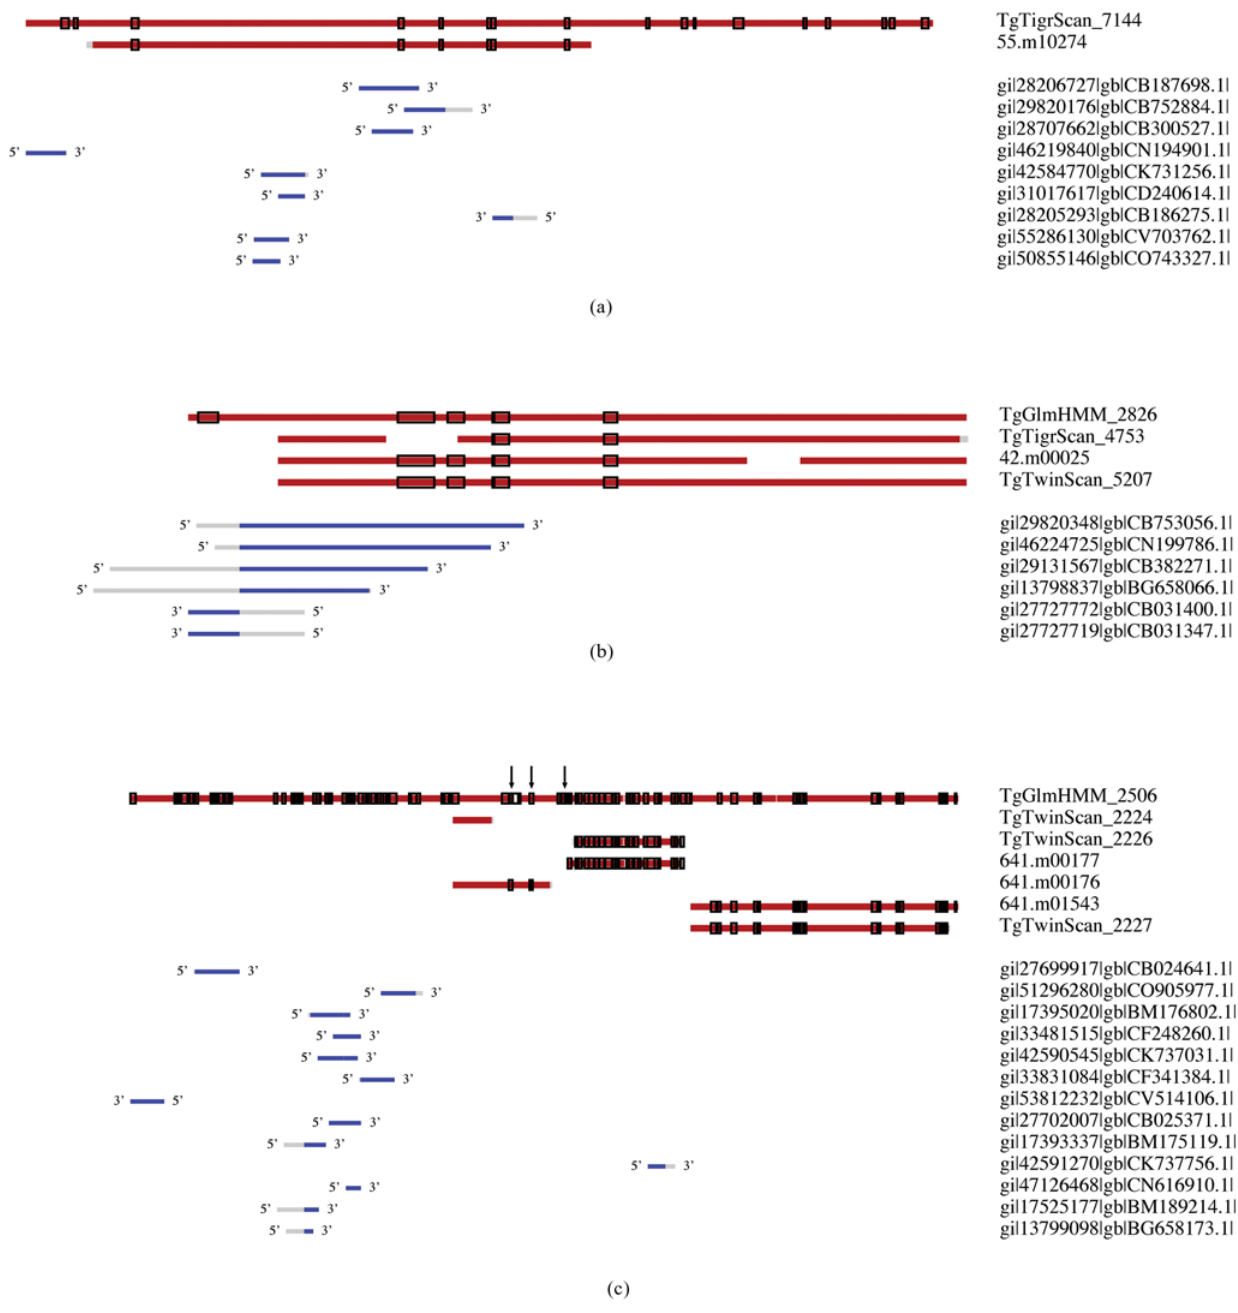
Figure 2. Examples of clusters of similar predicted amino acid sequences (red lines) with MS peptide hits (shown as open black blocks on amino acid sequences) and aligned ESTs (blue lines below amino acid sequence clusters), with EST translation directionality indicated. Grey lines indicate areas where sequences differ and are not aligned. Identifiers are listed on the right. a . Cluster of a TigrScan (TgTigrScan_7144) and Release4 (55.m10274) sequence. The TigrScan sequence has additional 5 9 and 3 9 regions (exons) compared to the Release4 sequence. The additional regions are verified by MS hits. There are no TwinScan, Glimmer, or known NR sequences in this MS validated coding region. b . Cluster of a Glimmer, TigrScan , Release4, and TwinScan sequence, all validated by MS peptide hits. The Glimmer sequence (TgGlmHmm_2826) has an additional MS validated 5 9 region. The TigrScan ( TgTigrScan_4753) sequence does not have an exon that is included in the Glimmer, Release4, and TwinScan sequences and that is supported by both MS and EST data. c . Cluster of a Glimmer (TgGlmHmm_2506) sequence, three TwinScan (TgTwinScan) sequences, and three Release4 sequences. The TwinScan and Release4 methods each predict three distinct proteins from this coding region whereas the Glimmer method predicts one. The distribution and location of the MS peptides on the Glimmer sequence indicates that the full length protein is likely to be present in the proteome. However, the shorter splice variants may also be real proteins. An example of the proteomics data confirming the existence of a continuous portion of the sequence is the group of MS peptides indicated by arrows.